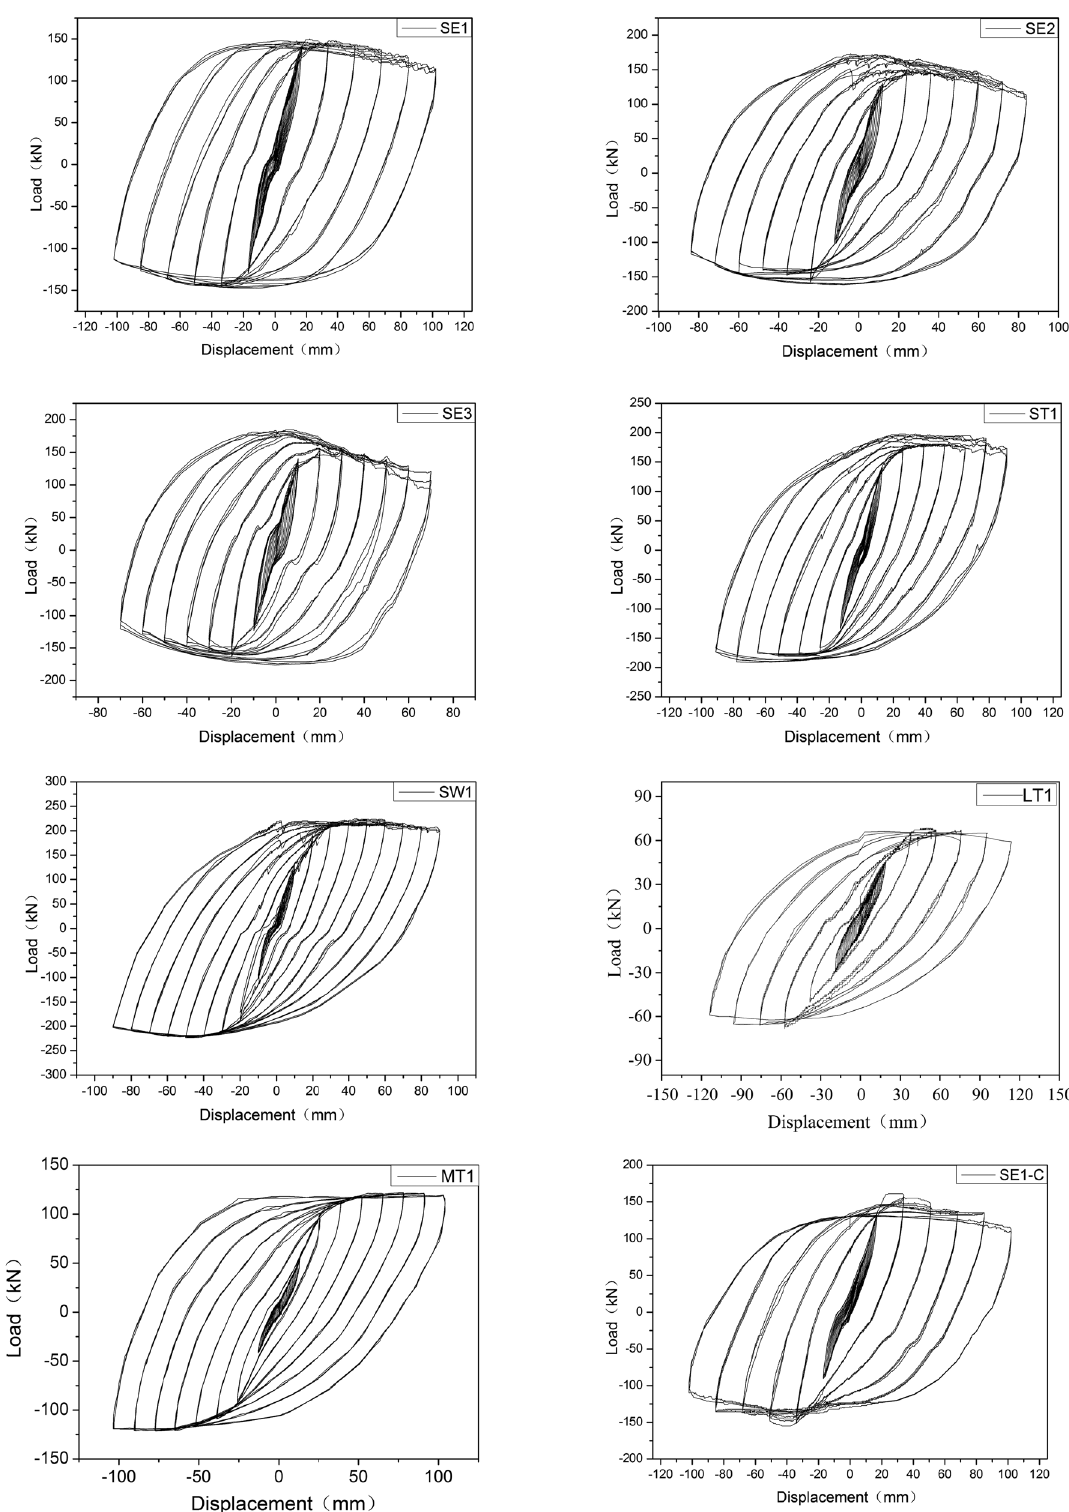
Figure 10: Hysteresis curve of typical